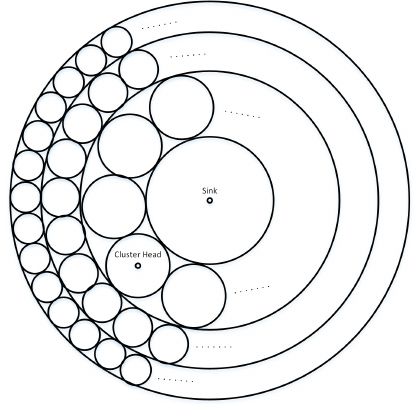
Figure 6. Overview of the unequally clustering in